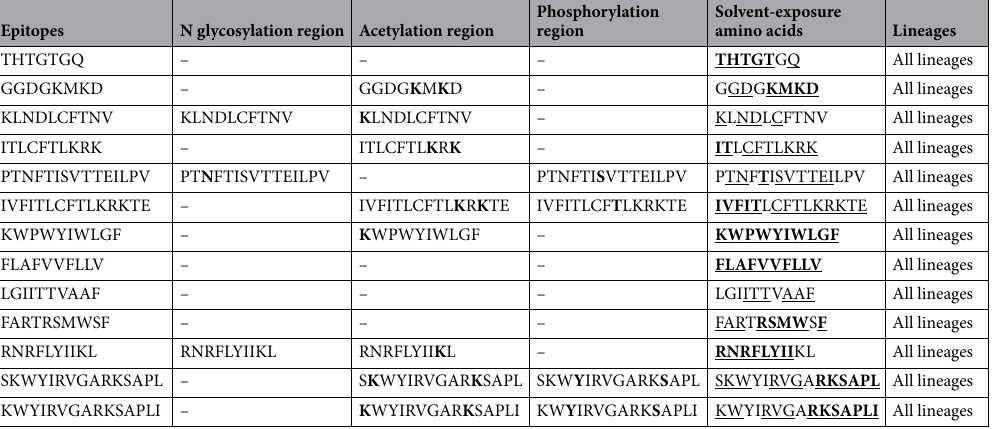
Table 9. Additional analysis performed for significant epitopes. Only underlined amino acid shows the moderate solvent exposure intensity. Both underlined and bold amino acids show the high solvent exposure intensity. Analysed common lineages are A, A.1, A.2, A.3, A.5, B, B.1, B.1.1, B.2, B.3, B.4.